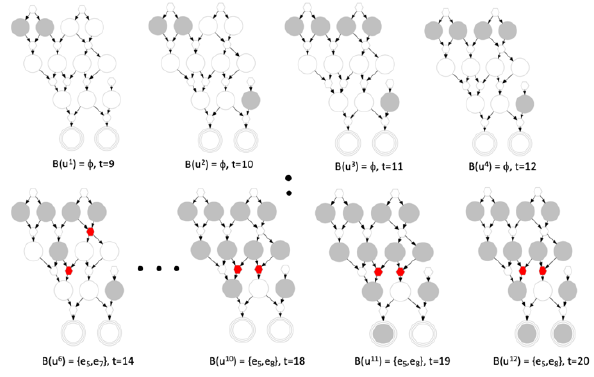
Figure 7. Sample evolution of deception policy when the attacker is in the fake network. Security state is represented by shaded node, and blocked exploits are represented by red shaped hyperedge.